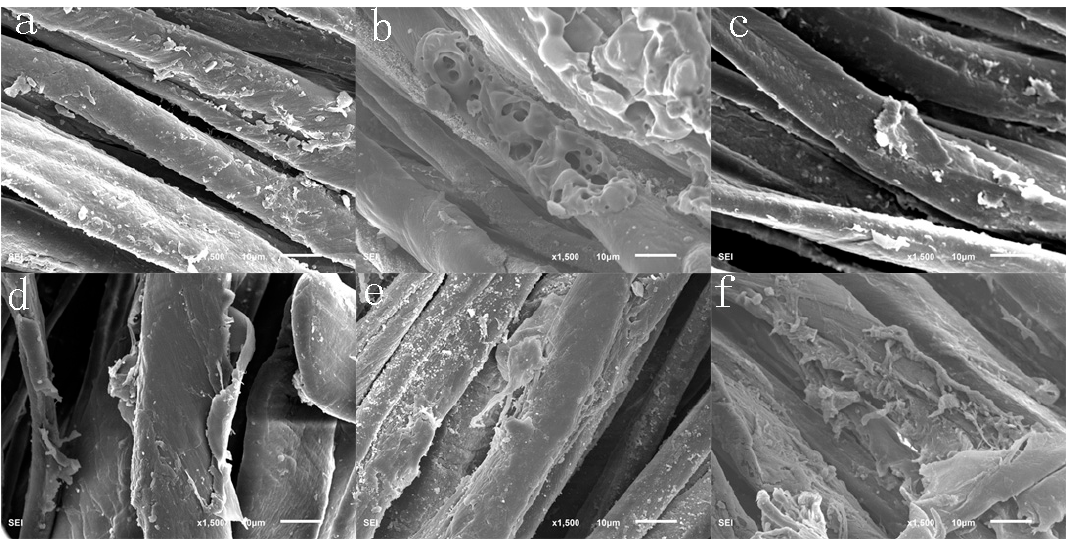
Figure 5. SEM pictures of different treatment of cotton denim fabrics (×1500): a Desized, b laser Figure 6. SEM pictures of di ff erent treatment of cotton denim fabrics ( × 1500): ( a ) Desized, ( b ) laser bleaching, c enzyme bleaching, d NaClO bleaching, e KMnO 4 bleaching, f H 2 O 2 bleaching. bleaching, ( c ) enzyme bleaching, ( d ) NaClO bleaching, ( e ) KMnO 4 bleaching, ( f ) H 2 O 2